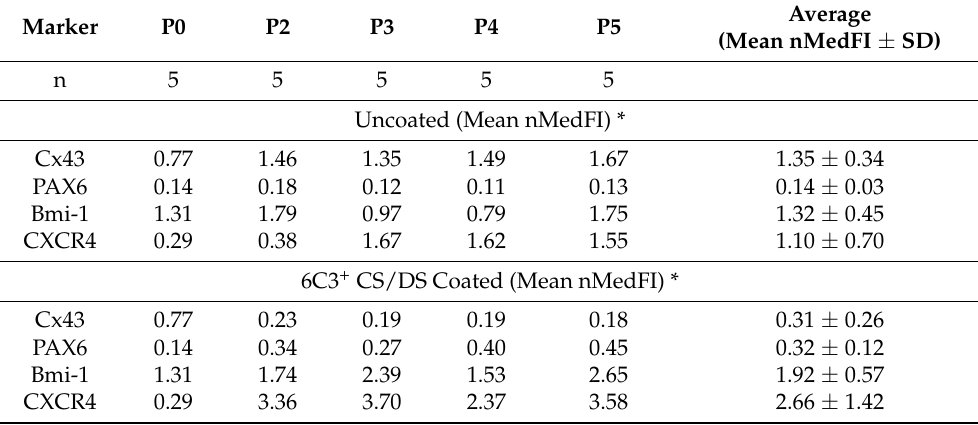
Table 1. Summary of indicative stem cell marker expression (nMedFI) across passages for E18 keratocytes cultured on uncoated and 6C3 + CS/DS coated culture plates.